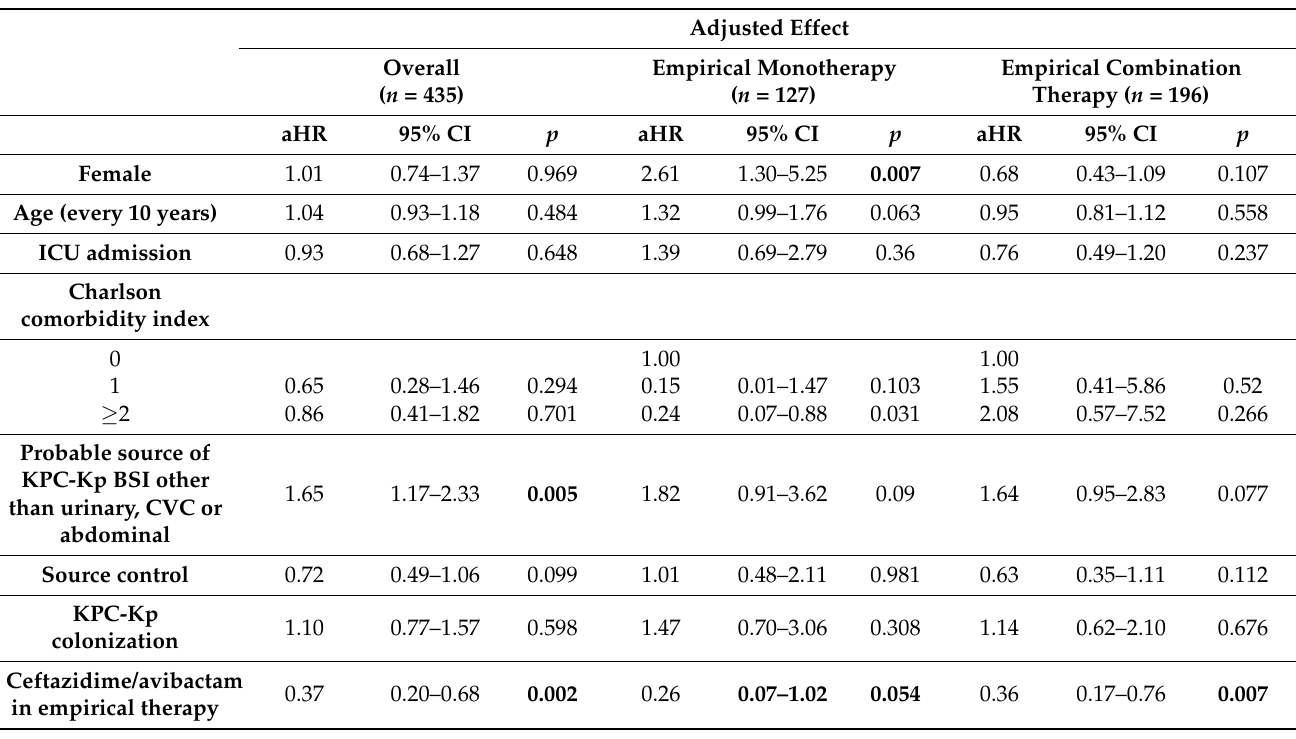
Table 5. Adjusted effect of ceftazidime/avibactam administration as a predictor of mortality in overall empirical therapy ( n = 435), empirical monotherapy ( n = 127) and empirical combination therapy ( n =